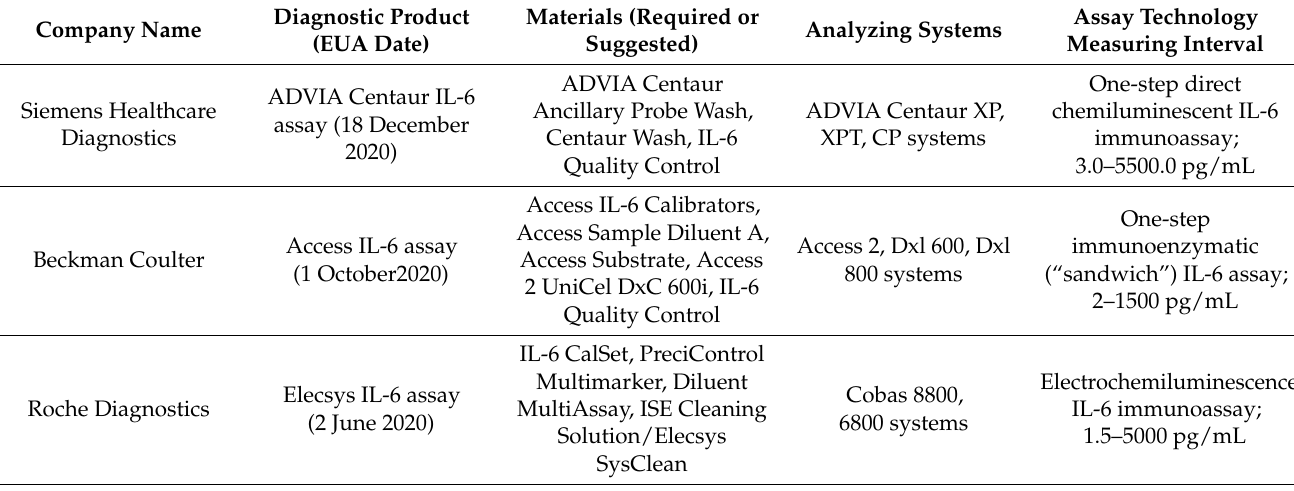
Table 5. Tests for the management of COVID-19 patients (IL-6 assays) granted FDA Emergency Use